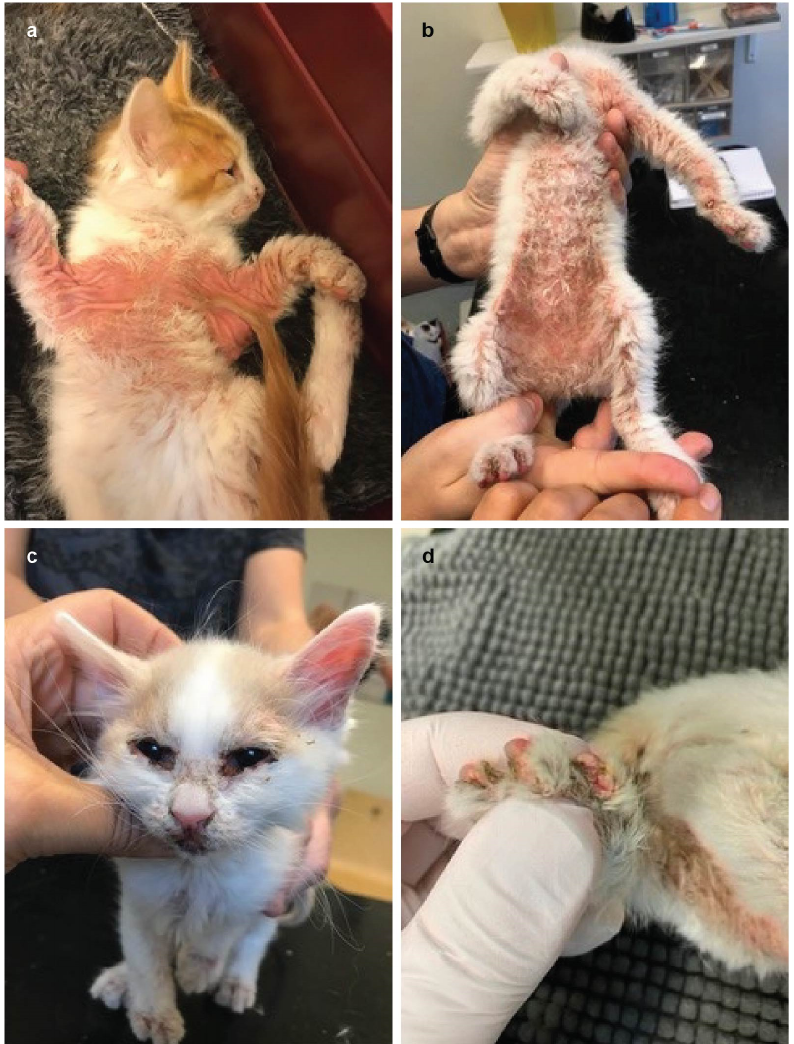
Figure 2. Clinical phenotype of cats affected with AE. ( a ) Skin disease with erythema and beginning alopecia on the ventrum. ( b ) More severe presentation with erythema, crusting, scaling, and alopecia on the ventral and distal aspects. ( c ) Characteristic skin lesions in the face and the ear pinnae. ( d ) Interdigital erosions. The histological findings were similar in all samples from the three kittens. The epidermis was mildly to moderately hyperplastic, and the granular cell layer was thin to absent.